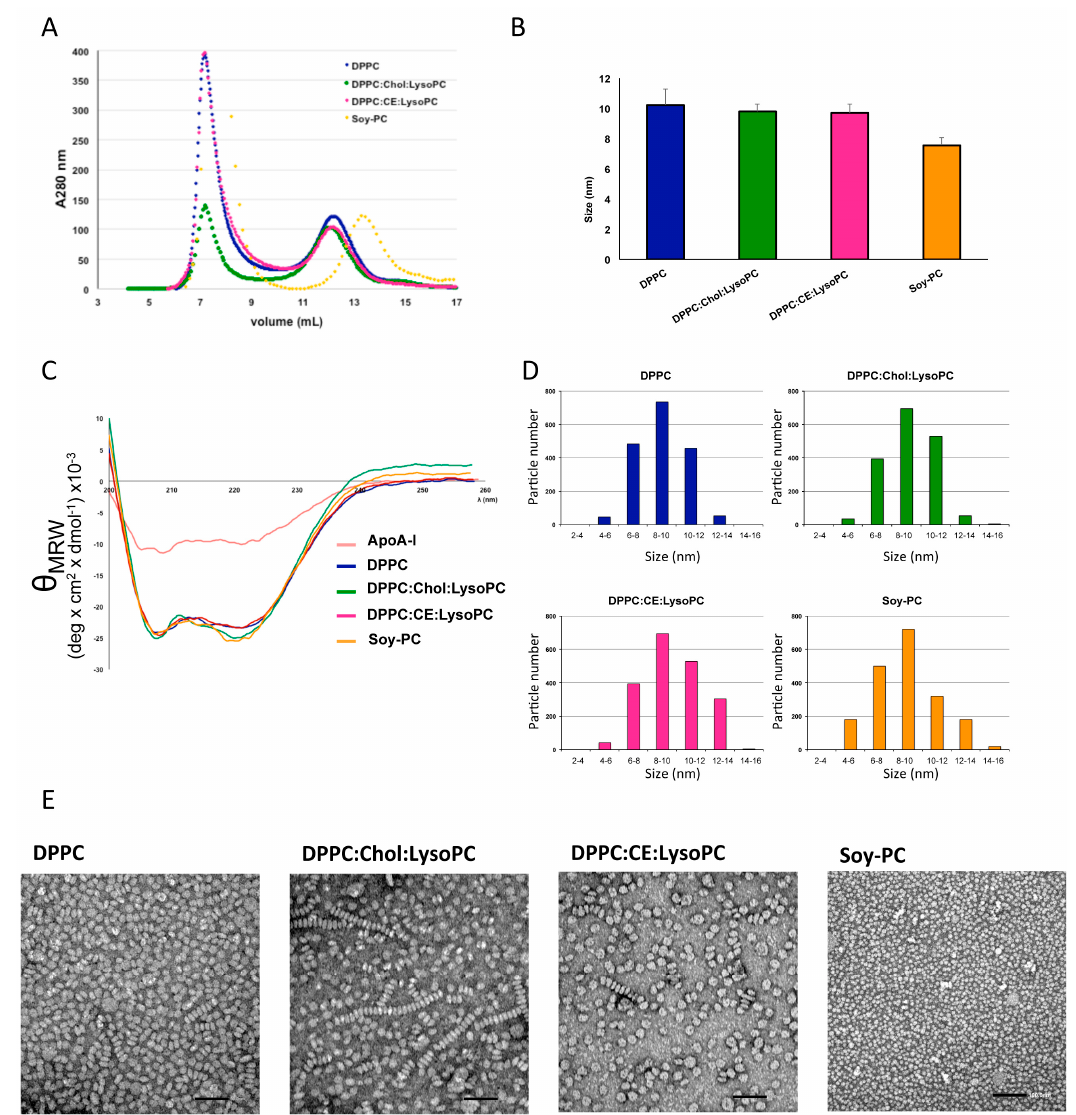
Figure 1. Development and biophysical characterization of rHDL. ( A ) Gel filtration profiles of rHDL reconstituted with different lipids and apoA-I. Nanoparticles were analyzed by gel filtration chromatography on a Superdex 200 column eluted at 4 °C. The profiles were monitored using absorbance at 280 nm. ( B ) rHDL size (hydrodynamic diameter) determination by dynamic light scattering (DLS). Each rHDL preparation present 9–10 nm diameter when analyzed trough DLS. No significant differences between different compositions. ( C ) Circular dichroism of rHDL preparations and apoA-I protein in solution at 25 °C in buffer TEN (pH 8). θ MRW : mean residue ellipticity. ( D ) Frequency histograms showing particle size distribution of rHDL determined from TEM images. ( E ) Representative rHDL transmission electron microscopy images. DPPC, DPPC:Chol:LysoPC (8.5:1:0.5), DPPC:CE:LysoPC (7.5:2:0.5) and Soy-PC. Magnification 100 × . Scale bar of 100 nm. rHDL size distribution in ( D ) was measured as Feret diameter calculated from 1600